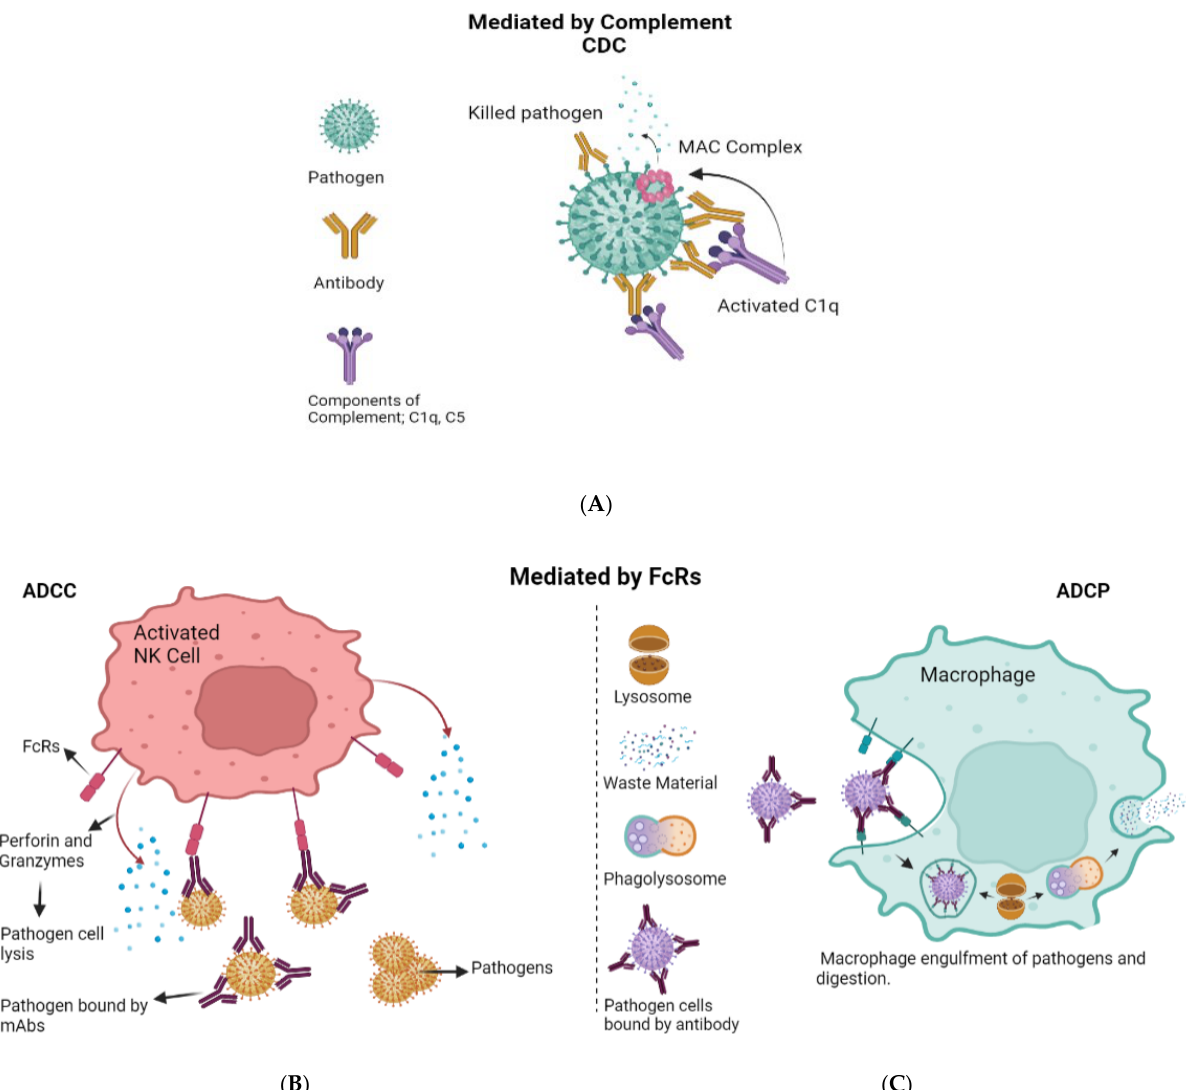
Figure 1. Antibody effector functions. ( A ) Complement-dependent cytotoxicity (CDC). When an antibody binds to an antigen on the cell surface, the complement component C1q is activated